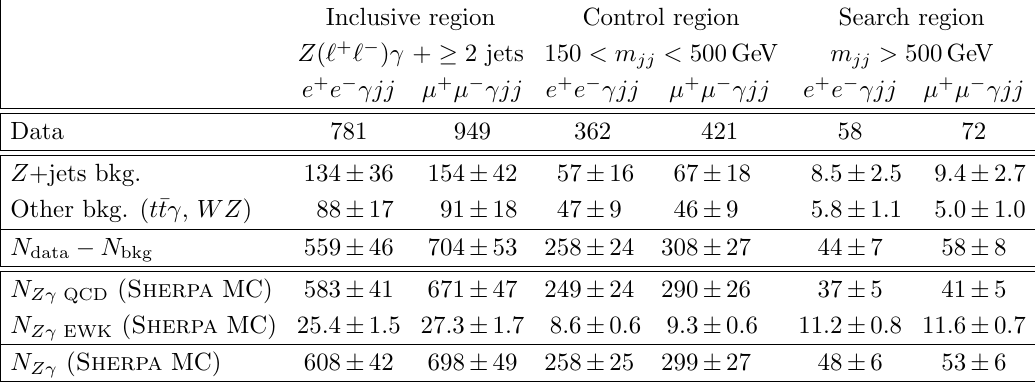
Table 1 . Summary of events observed in data and estimated composition for the Z ( e + e (cid:0) ) (cid:13)jj and Z ( (cid:22) + (cid:22) (cid:0) ) (cid:13)jj production processes. The Z +jets contribution in this table is taken as a (cid:12)xed fraction, (23 (cid:6) 6)%, of N Z(cid:13) QCD . The last line corresponds to the sum of the two previous lines ( N Z(cid:13) QCD + N Z(cid:13) EWK ). The uncertainties correspond to the statistical and systematic uncertainties added in quadrature.